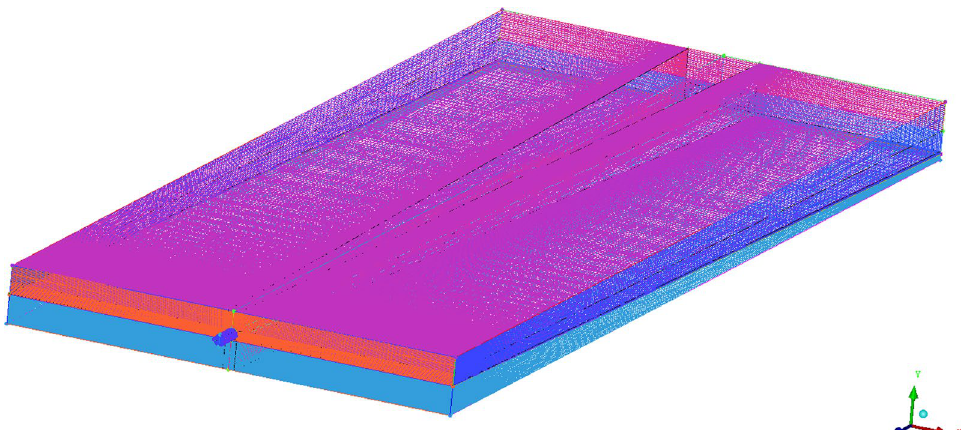
Fig. 9 Grid diagram of the numerical simulation of filling reclamation with Yellow River sediments